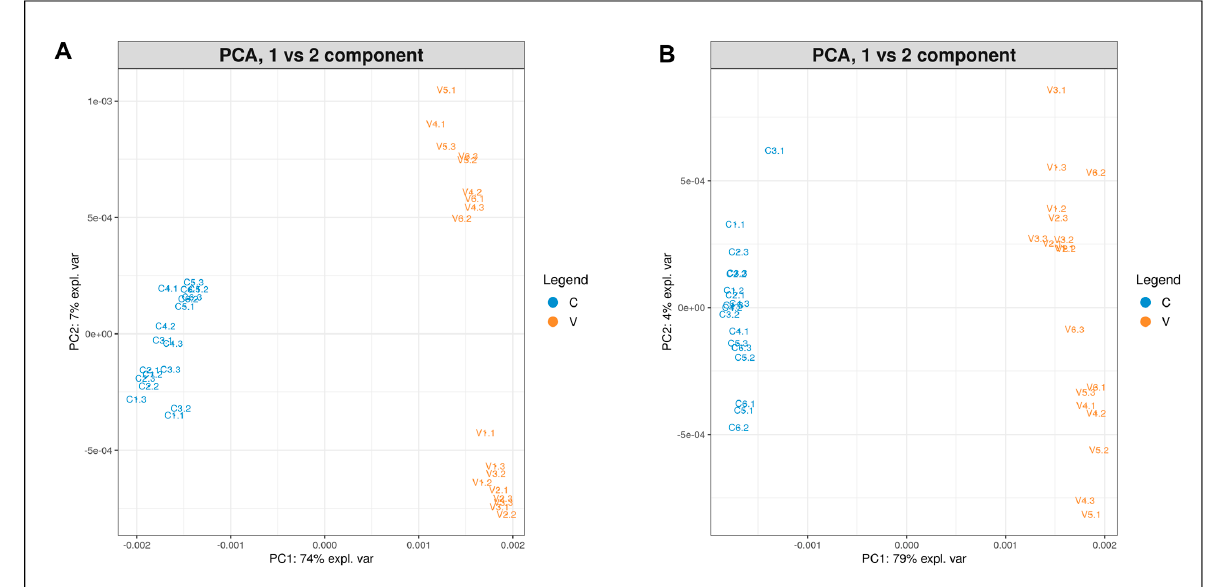
Figure 7. PCA plot (PC1 vs. PC2) of albumin ( A ) and globulin ( B ) extracts from Secuieni J. certified seeds (C, blue) and harvested seeds from the experimental field of Viganella (V, orange).